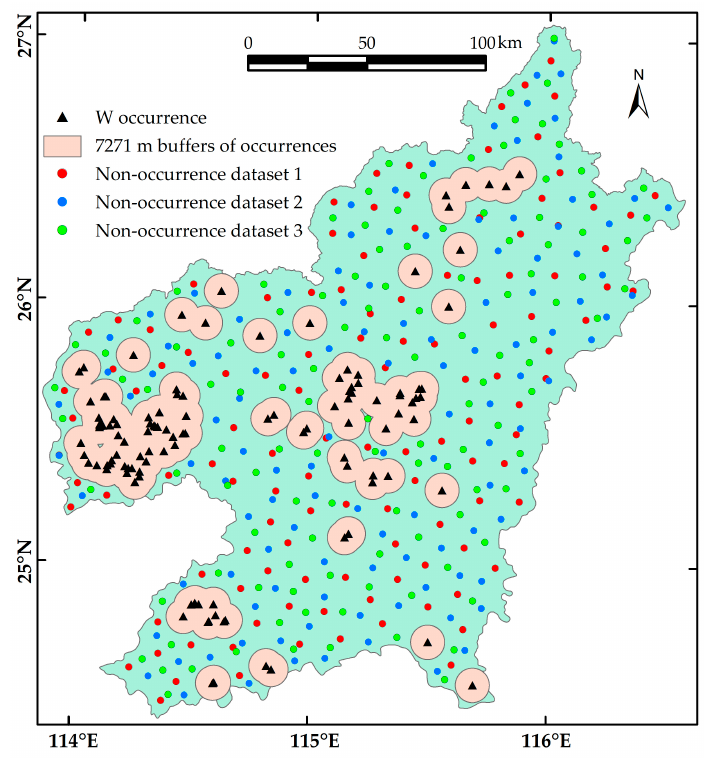
Figure 7. Locations of known mineral occurrences and selected non ‐ occurrences.